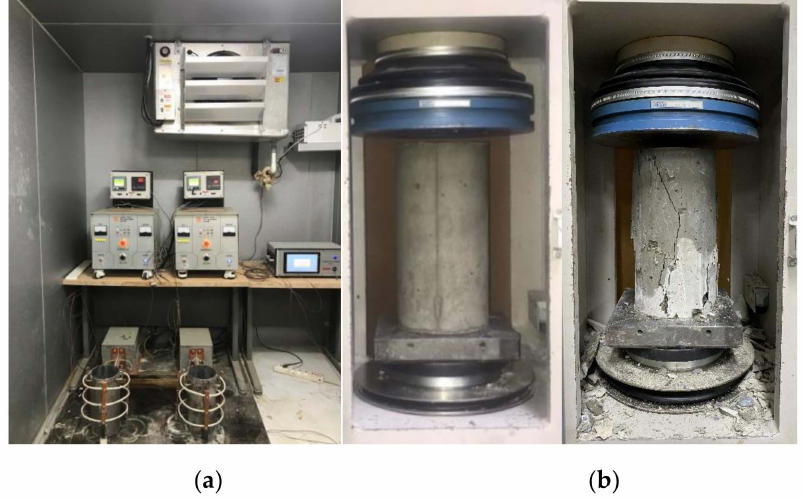
Figure 8. Test setup for induction heat curing and compression test: ( a ) test chamber, specimens, and setup for IHC; ( b ) setup for compression